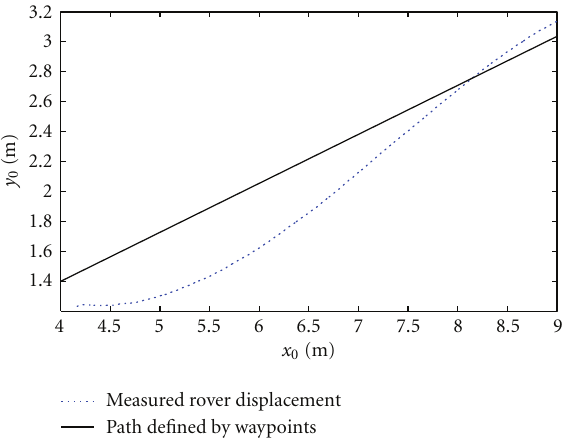
Figure 7: Experimental result of the path following control in nominal mode, vehicle starts in position and orientation indicated in the left-bottom part of the